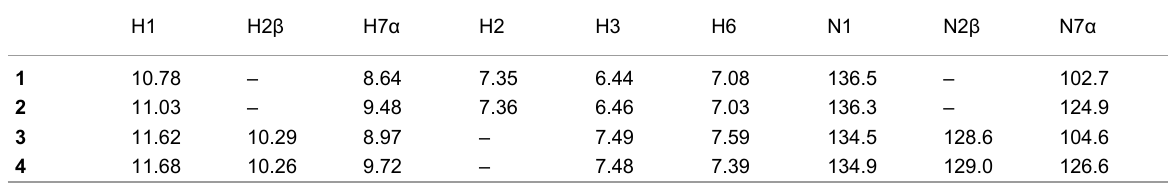
Table 2: Selected 1 H and 15 N NMR chemical shifts for 1 – 4 (in ppm). a